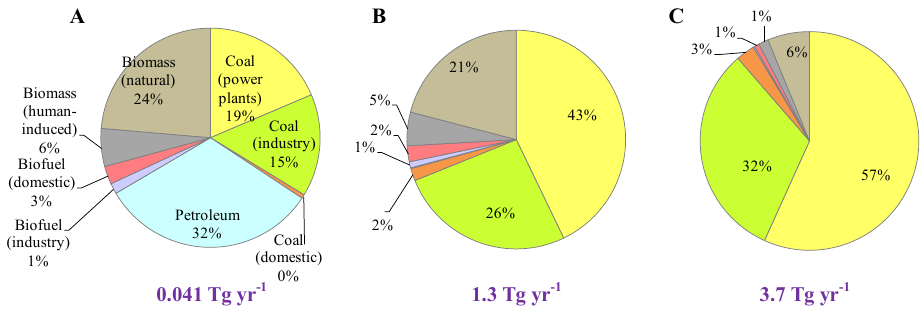
Figure 2 Figure 2. Source profiles of Fe from combustion for PM 1 (a) , PM 1 − 10 (b) , and PM > 10 (c) as an average for 1960–2007. The total Fe emission for each size class is provided under its pie chart.